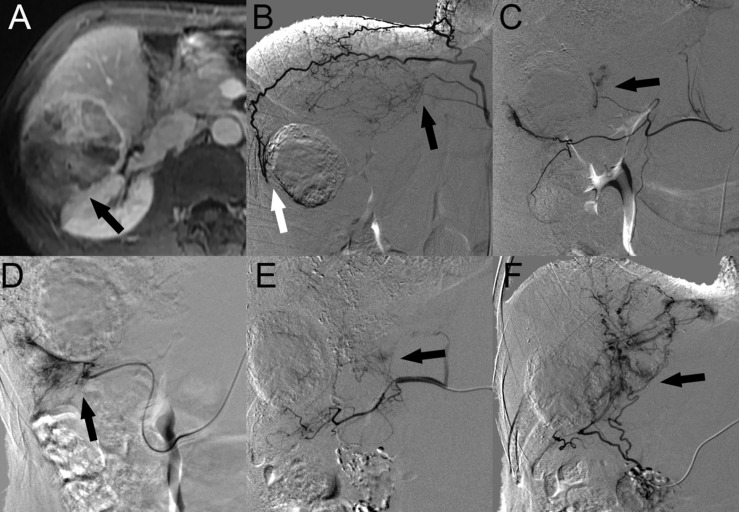
HCC with RAPS invasion in a 51-year-old man. (A) Contrast-enhanced portal phase MR image showed a 7.6-cm-sized tumor (black arrow) in segment 6 of the right lobe of the liver invading the RAPS in the axial plane. (B) Angiographic image at the first recurrence revealed that both the superior branch of the RAA (black arrow) and the posterior branch of the RIPA are involved in the tumor blood supply (white arrow). (C) Angiographic image at the TACE session to the first recurrence revealed that the tumor was also supplied by the middle branch of the RRCA (black arrow). (D) Angiographic image at the second recurrence revealed that the EHCs were supplied by the accessory omental artery (black arrow). (E) After the fourth chemoembolization session, the SA was involved in the tumor blood supply (black arrow). (F) At the last TACE session, the tumor was supplied by the right omental artery (black arrow). Abbreviations: HCC, hepatocellular carcinoma; RAPS, right anterior pararenal space; RIPA, right inferior phrenic artery; RRCA, right renal capsular artery; RAA, right adrenal artery; and SA, supraduodenal artery.